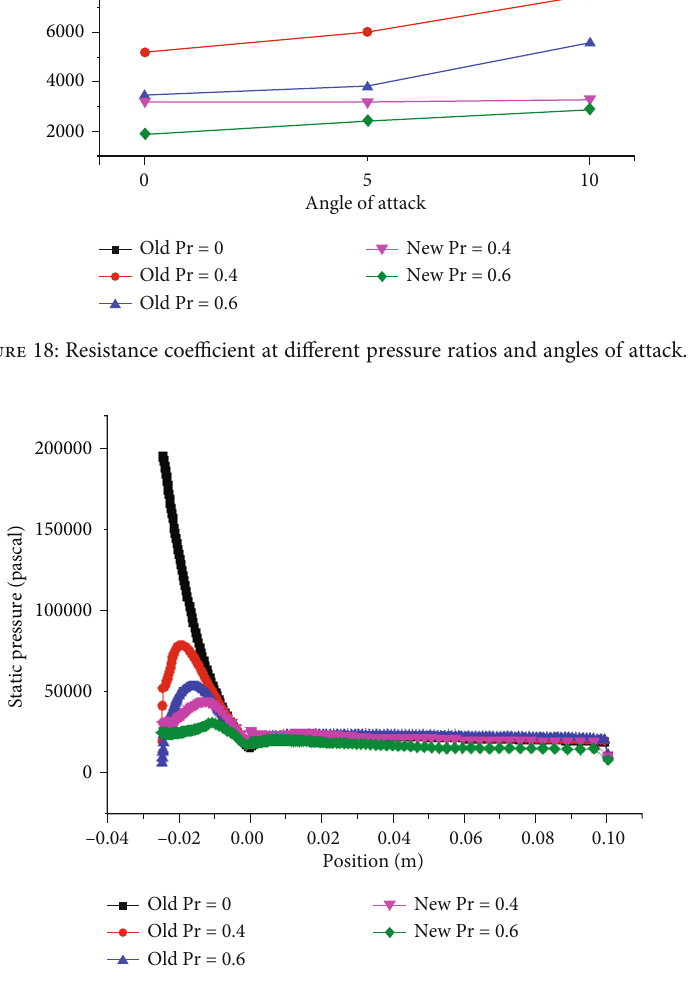
Figure 19: Wall pressure distribution diagram with di ff erent pressure